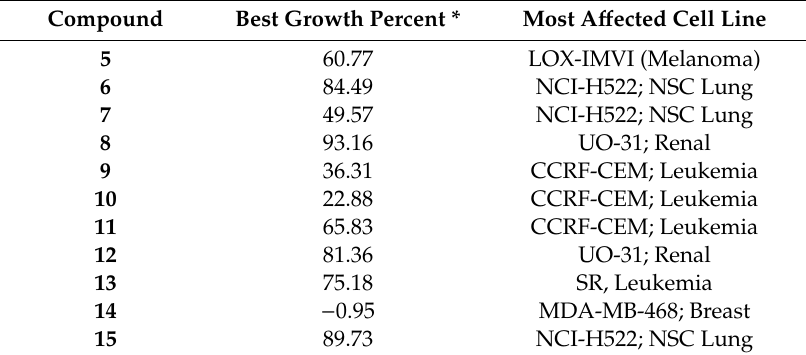
Table 1. Best Growth Percent and Target Cell Line for Compounds 5 – 15.